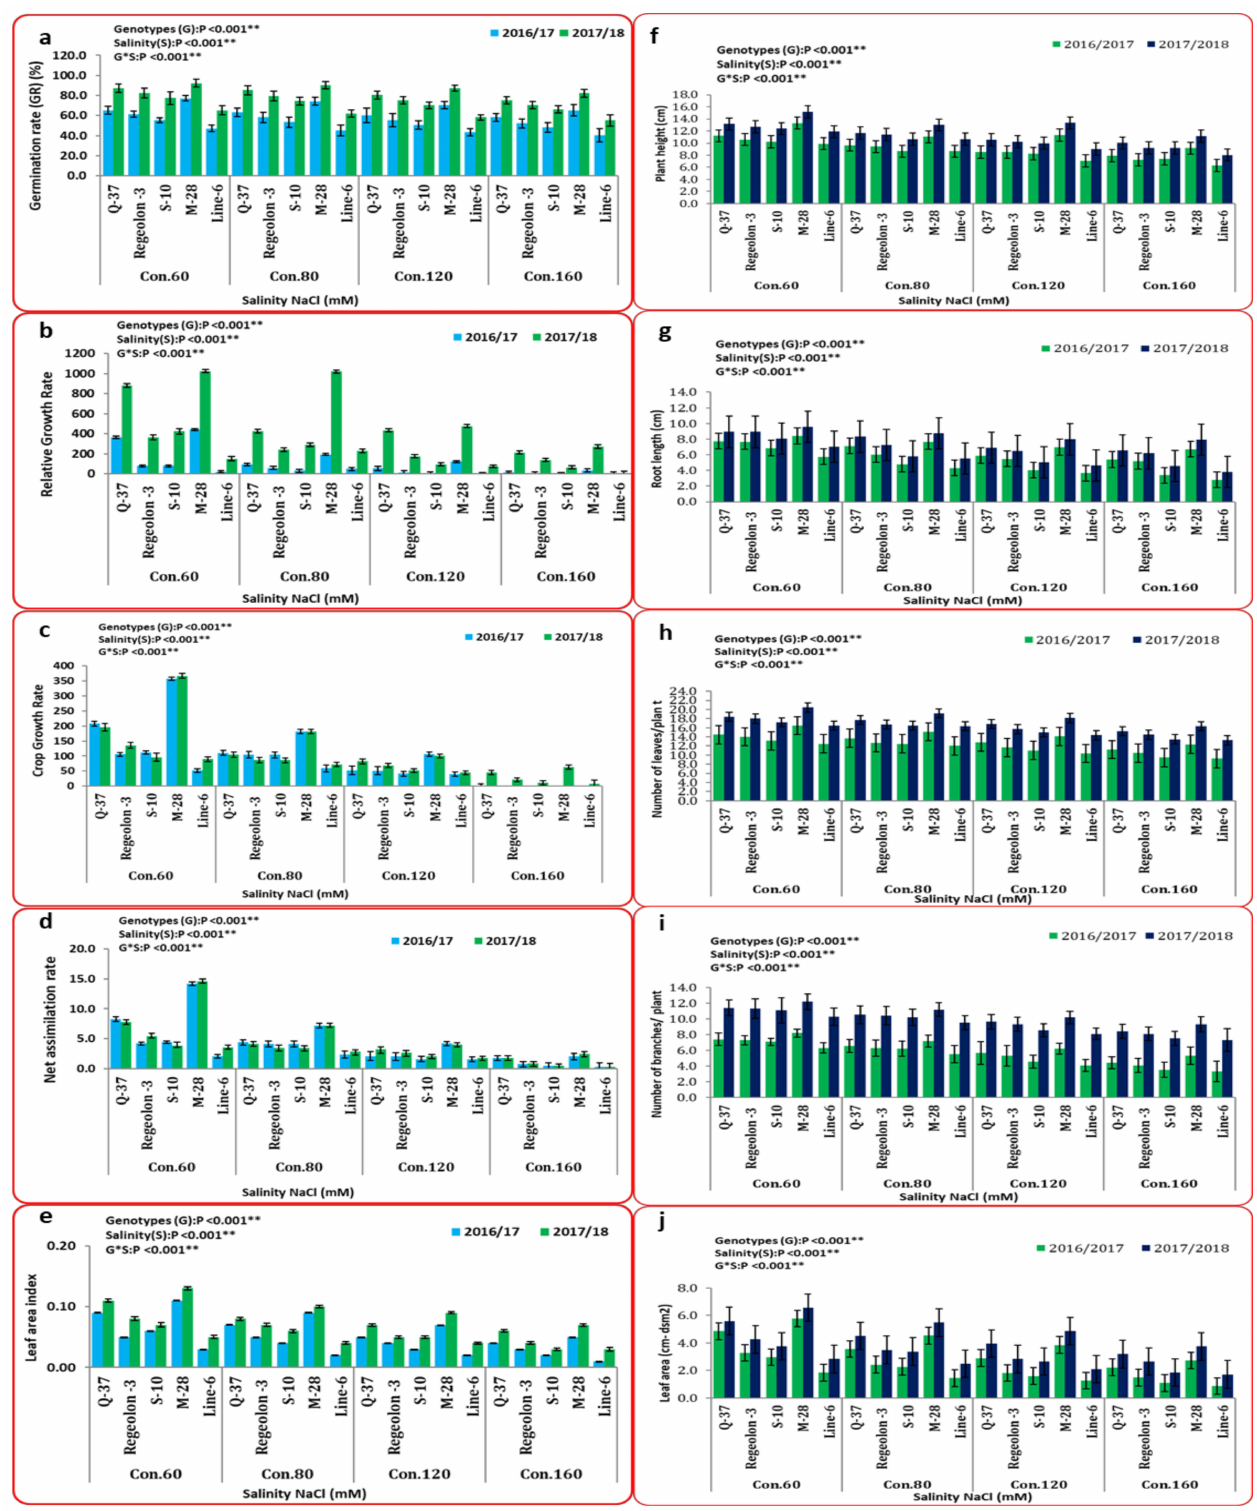
Figure 2. Mean performance (combined data of two seasons) represented as (mean ± SD) for ( a ) germination rate, Growth traits: ( b ) relative growth rate, ( c ) crop growth rate, ( d ) net assimilation rate, physiological traits: ( e ) leaf area index, ( f ) plant height (cm), ( g ) root length (cm), ( h ) number of leaves/plants, ( i ) number of branches/plants, and ( j ) leaf area. All data are means of three replicates. Two-way ANOVA was performed to determine the effect of different quinoa genotypes on the studied traits. For all statistical tests, p values ≤ 0.01 ** were considered highly statistically significant.at 0.01% probability